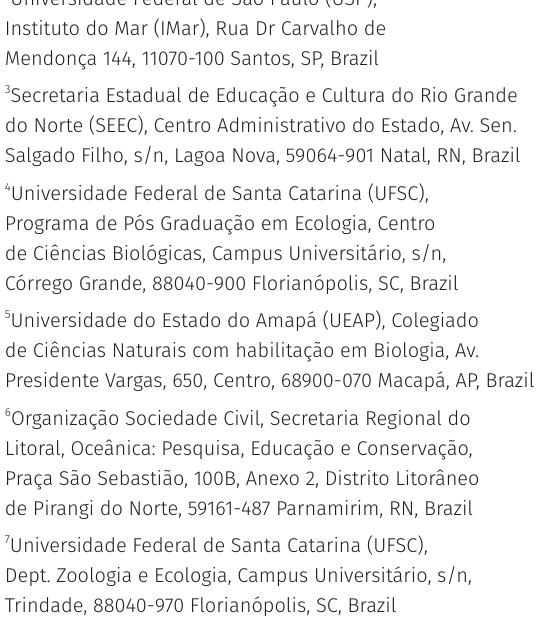
Table SIV. List of fishes recorded at different habitats of the eastern coast of RN with their respective human use. The categories were classified as: Aquarium (A), Consumption (C), Craftsmanship (CR), Fishery discard (F), Recreational fishing (R), Medicine (M) and not available or unknown (NA). Species are listed